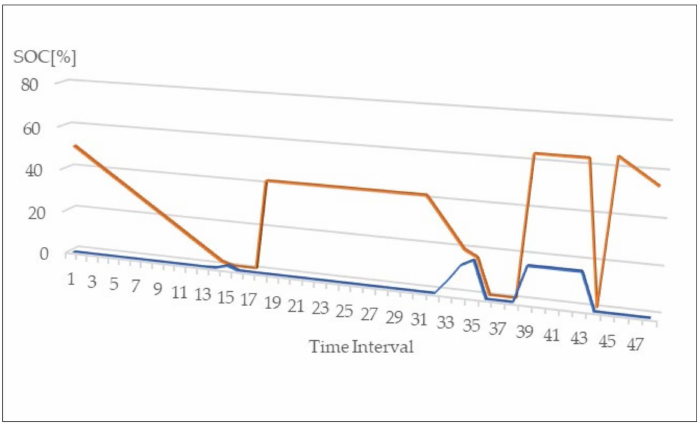
Figure 12. Mobility pattern 3—daily profile of downward (orange) and upward (blue)